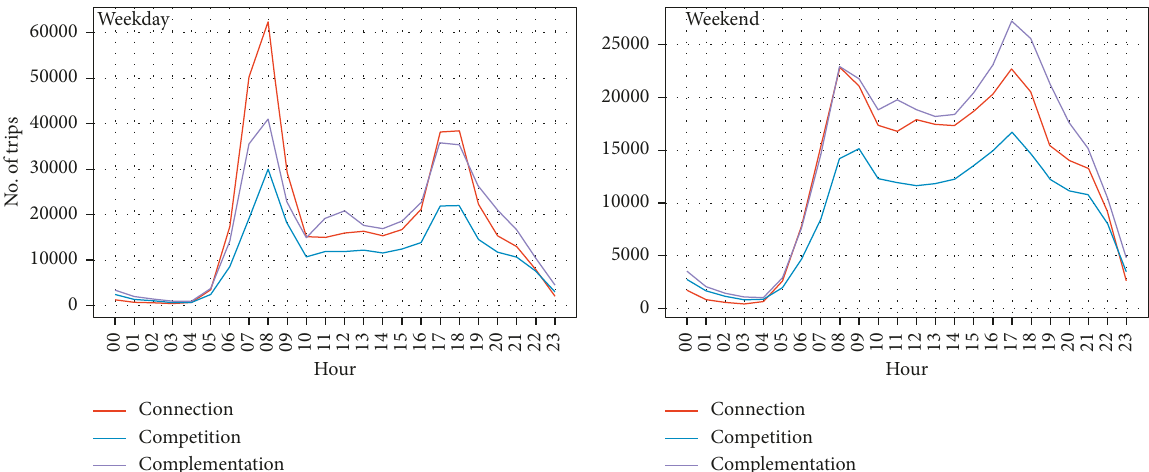
Figure 9: The hourly variation of the number of connection, complementation, and competition trips.